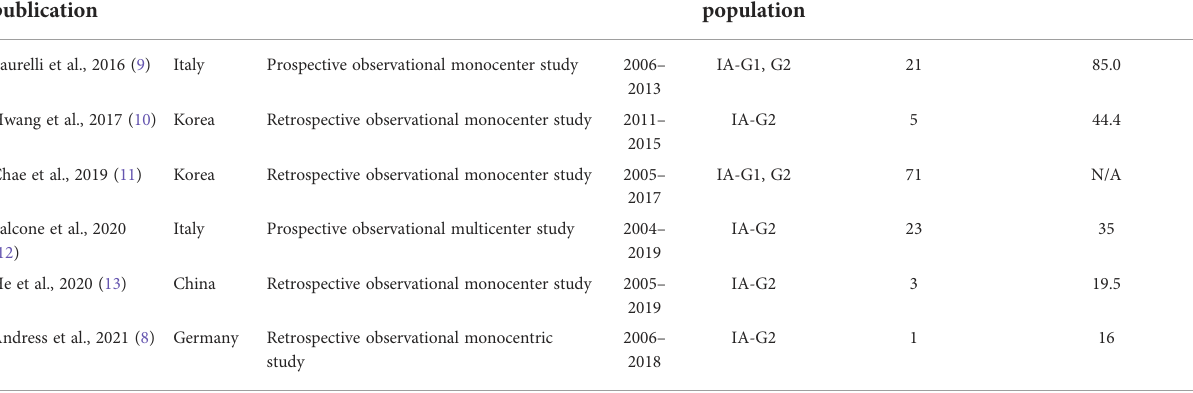
TABLE 1 Characteristics of included studies.